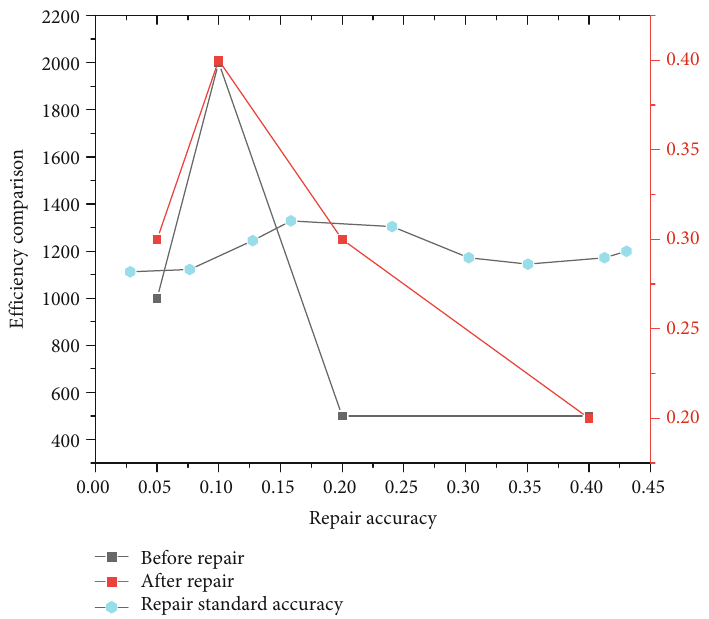
Figure 8: Accuracy comparison chart before and after image restoration.